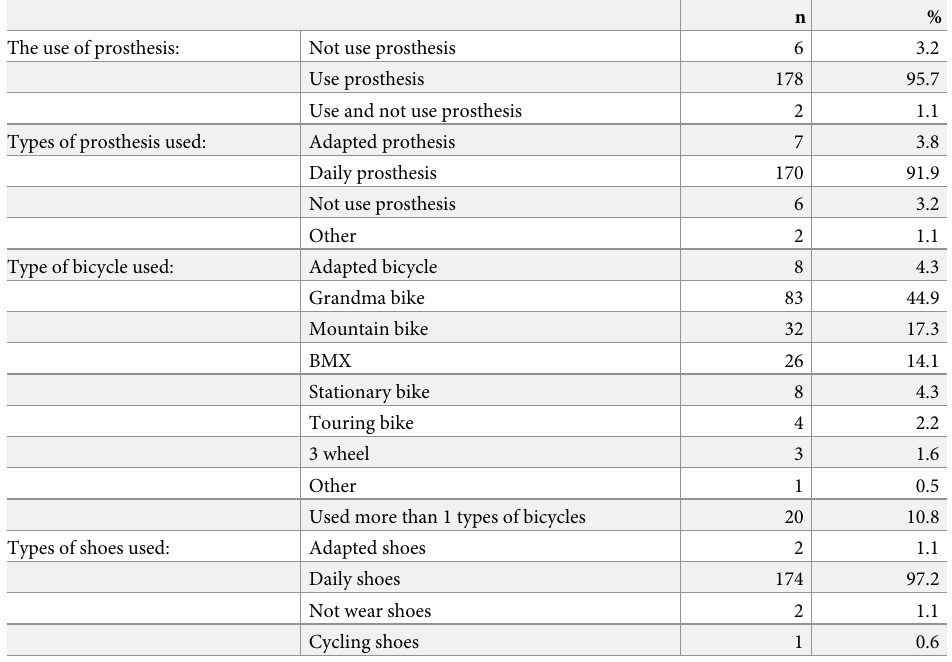
Table 5. Daily prosthesis, walking aids and shoes of cyclists (n =